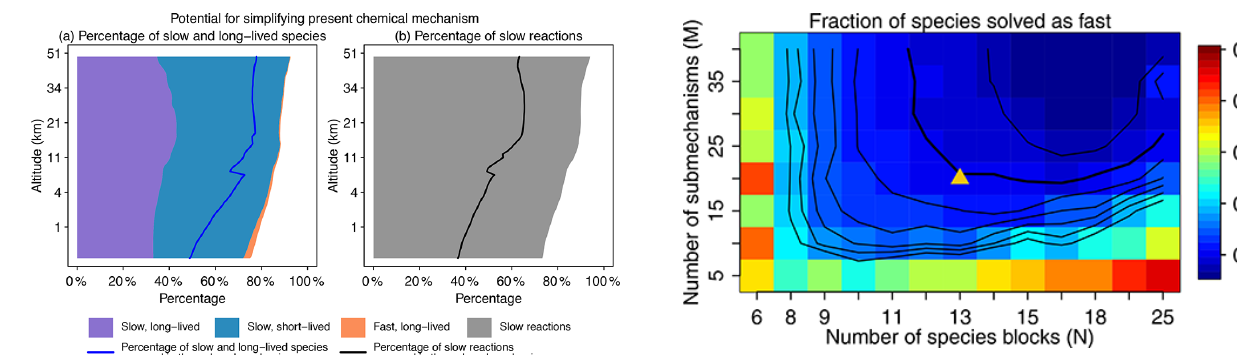
Figure 2. Potential for simplifying the full chemical mechanism in a global GEOS-Chem model simulation. Panel (a) shows the percentage of slow and long-lived species by altitude when aver- aged globally on 1 August 2013 at 00:00GMT. We use a thresh- old of 500 moleculescm − 3 s − 1 to partition fast ( P or L is > 500 moleculescm − 3 s − 1 ) and slow species ( P and L are both < 500 moleculescm − 3 s − 1 ) and a lifetime of 10d to separate long- lived and short-lived species. The blue line denotes the percentage of slow and long-lived species that are actually removed in the re- duced mechanism. Panel (b) shows the percentage of slow reac- tions ( < 10 moleculescm − 3 s − 1 ) by altitude. The black line is the percentage of slow reactions actually removed in the reduced mech- anism.